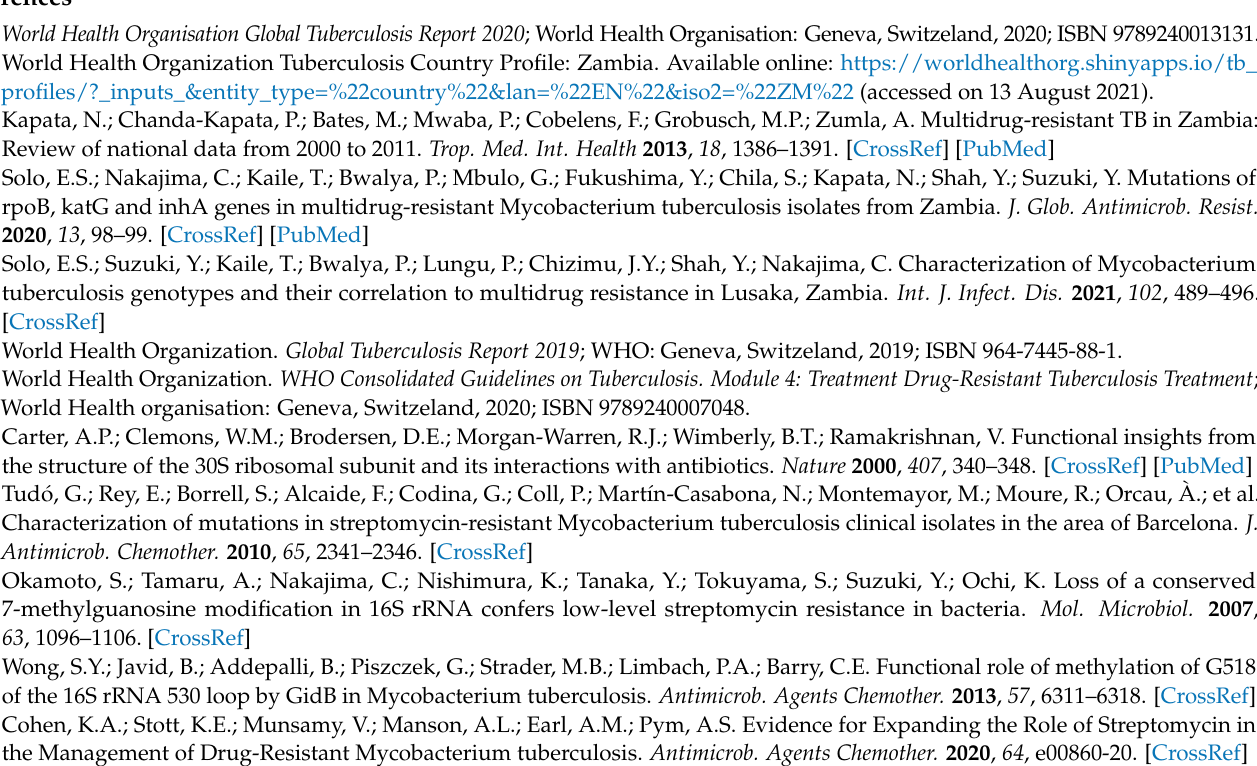
Table S3: The occurrence of K43R in various lineages among 7346 global MDR, pre-XDR, and XDR-MTB